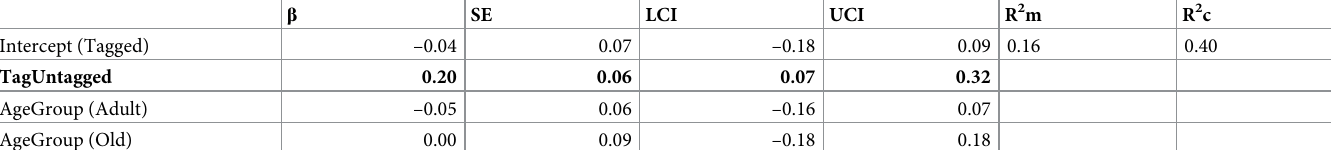
Table 3. Effect size ( β ), adjusted standard error (SE), lower (LCI), and upper (UCI) 95% confidence interval of explanatory variables in the most parsimonious model analyzing percentage daily body weight change between two subsequent captures of Eurasian beavers ( Castor fiber ) in southeastern Norway (2006–2020). The intercept includes the ‘young’ age group of beavers. The informative parameters are shown in bold, and the marginal (R 2 m) and conditional (R 2 c) R squared is given for the model overall.